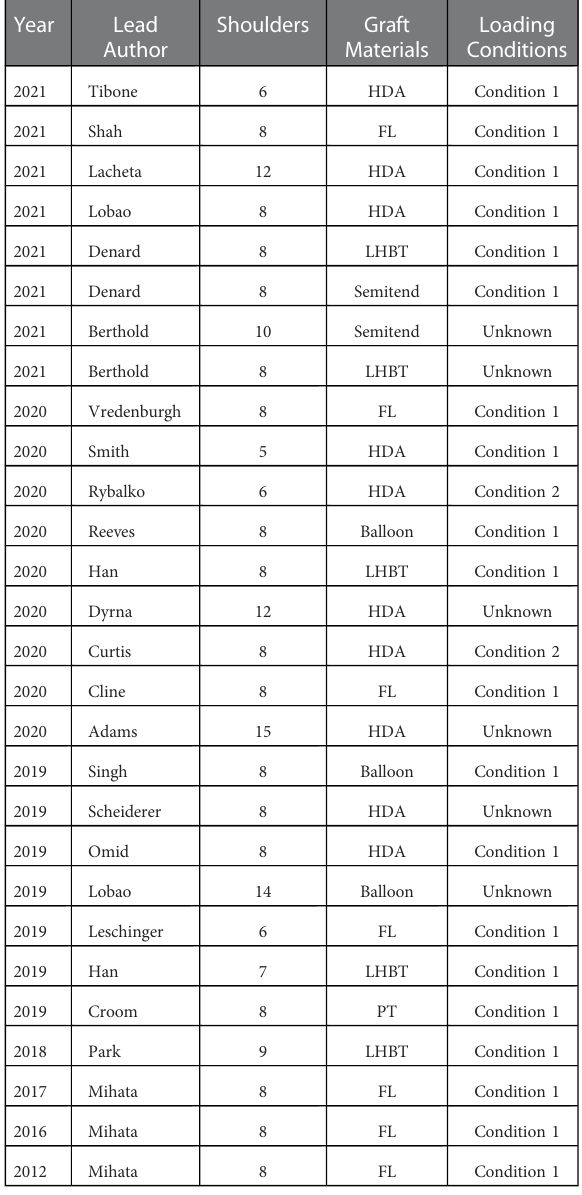
TABLE 1 Study characteristics of studies included in the